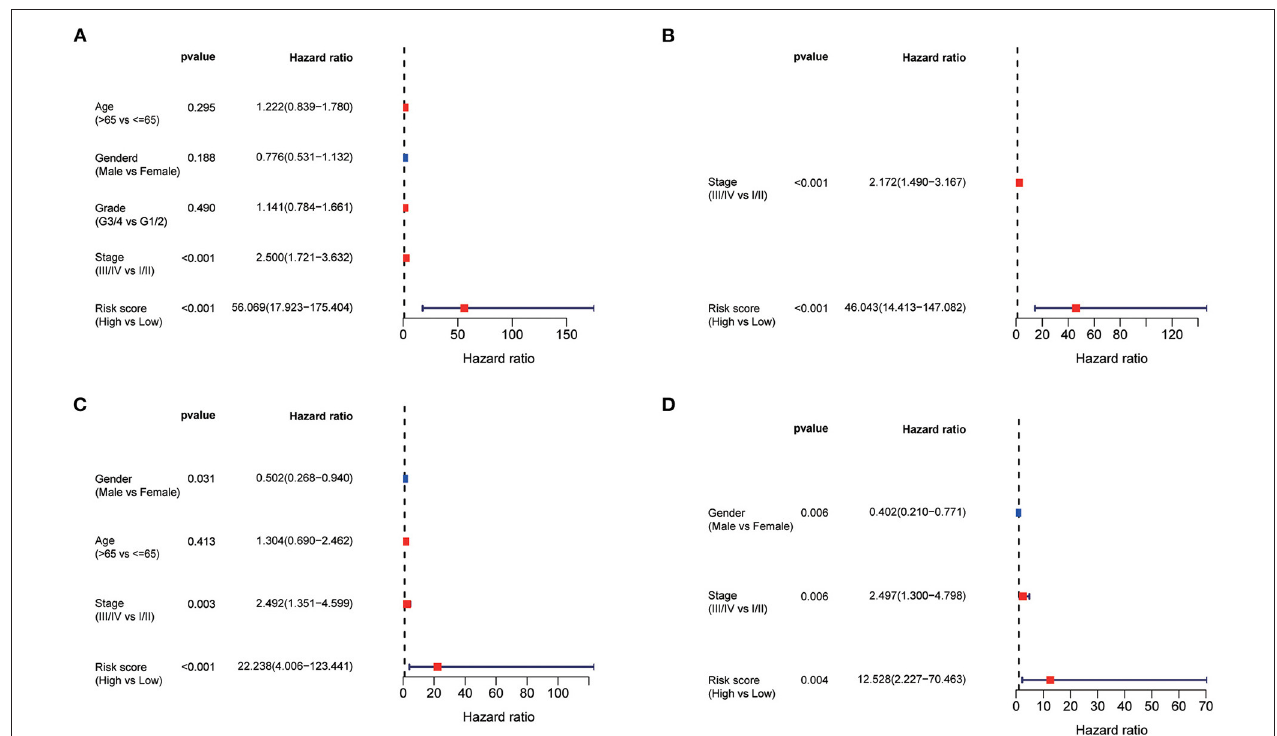
FIGURE 5 | Univariate and multivariate Cox regression analysis of prognosis in HCC patients. Forest plot of the univariate and multivariate Cox regression analysis regarding OS in the TCGA derivation set (A,B) and the ICGC validation set (C,D)